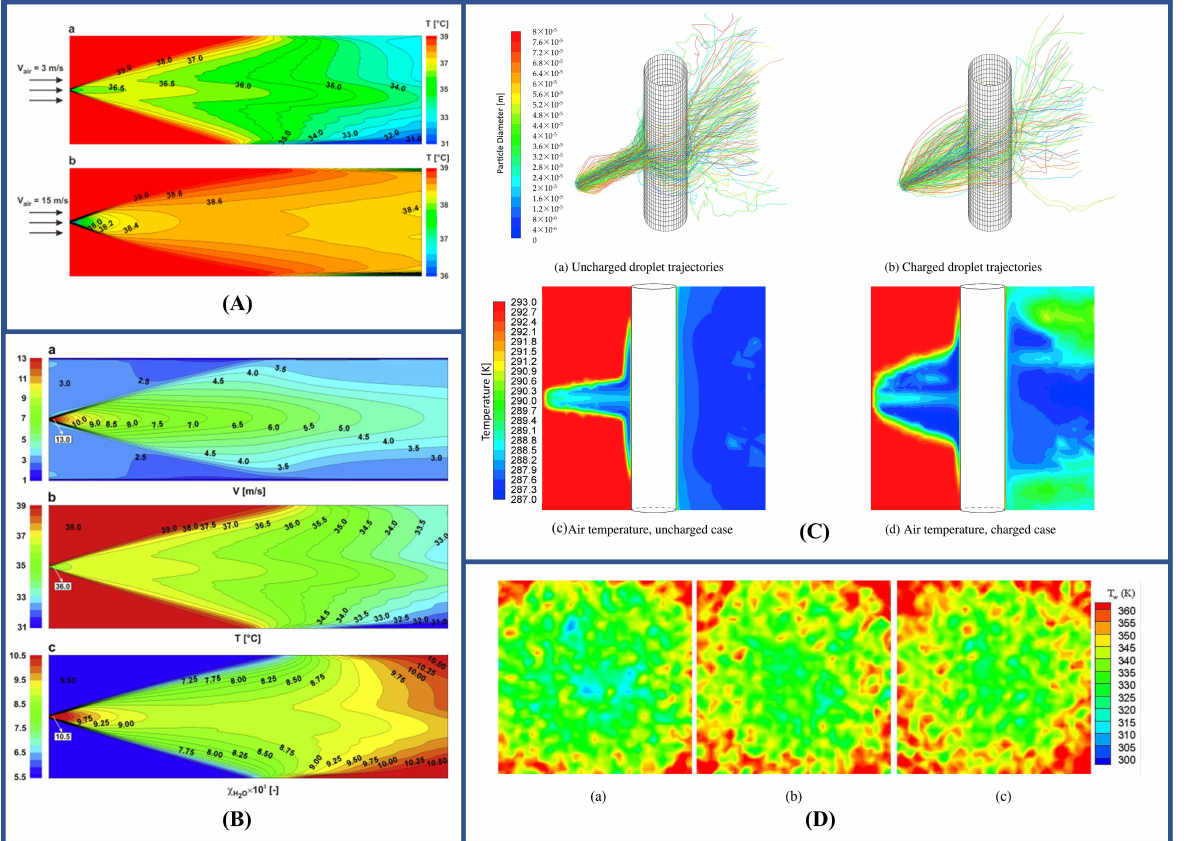
Figure 8. CFD simulation and analysis of spray cooling process. ( A ): Temperature distribution in cross-section (centre plane) for cases ( a ) ∆U = 19 m/s and ( b ) ∆U = 7 m/s [135]. ( B ): Air velocity, temperature and vapor mass fraction distributions in cross-section (center plane) [137]. ( C ): ( a , b ): Droplet trajectories of uncharged and charged droplets, colored by diameter; ( c , d ): air temperature at a vertical section of the regime [144]. ( D ): The temperature of liquid film at different initial temperatures ( a ) Tin = 297 K; ( b ) Tin = 301 K; ( c ) Tin = 303 K [145].